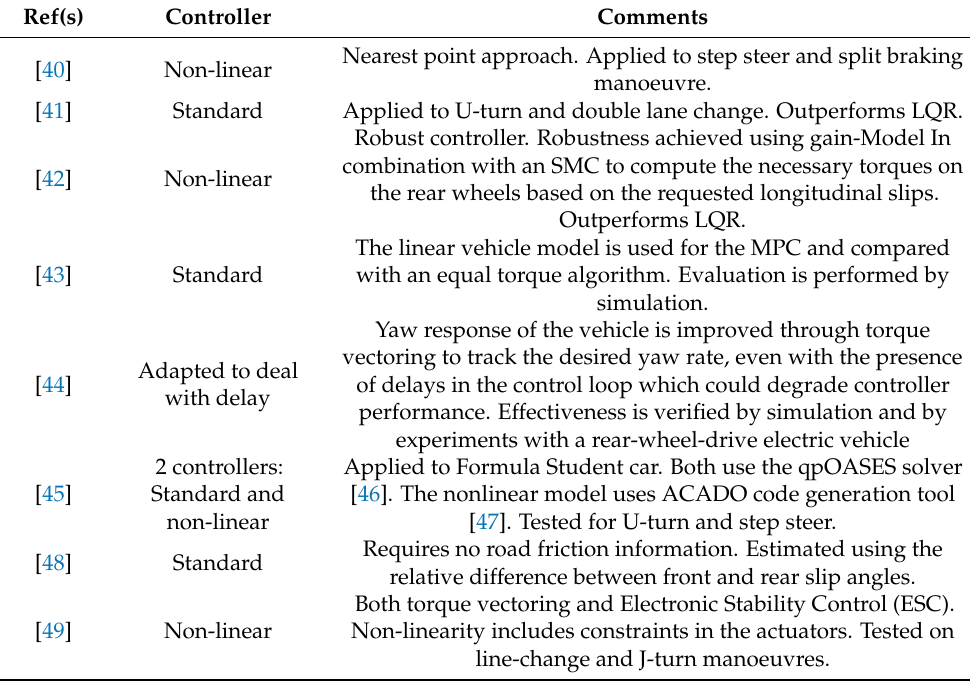
Table 5. Model Predictive Control (MPC) applied to